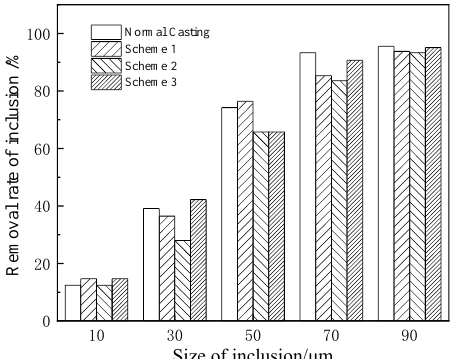
Figure 8. Inclusion removal rate of each scheme in tundish.